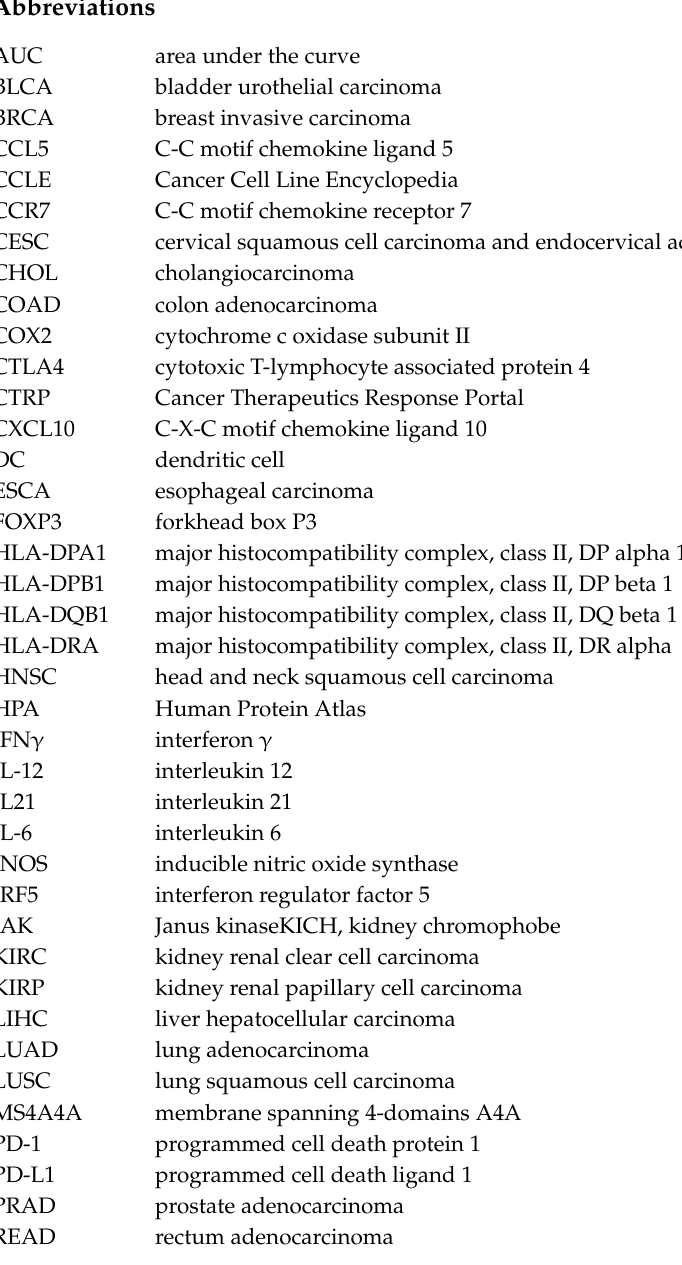
Figure S1: STAT3 expression and drug response correlation in 10 types of cancer cell lines, Table S1: Correlation analysis between STAT3 and gene markers of immune cells in